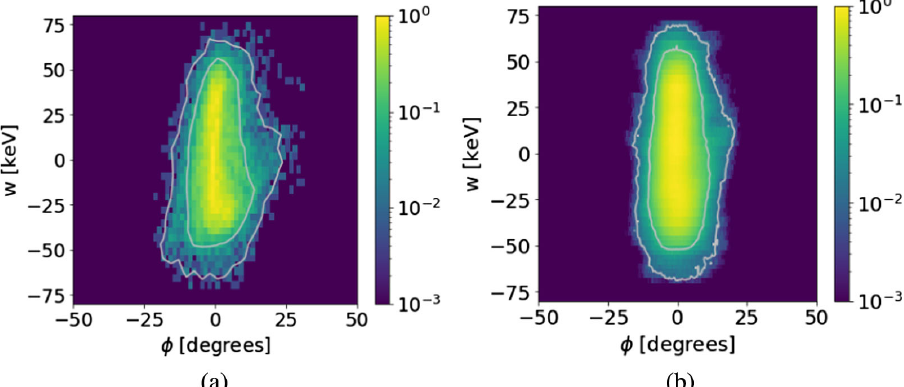
ˆ f ð ϕ ; w Þj FIG. 19. Comparison between ˜ x; ˜ x at (a) the first slit and (b) after reconstruction through the emittance apparatus with finite slit widths. 1% and 10% contour lines are drawn.